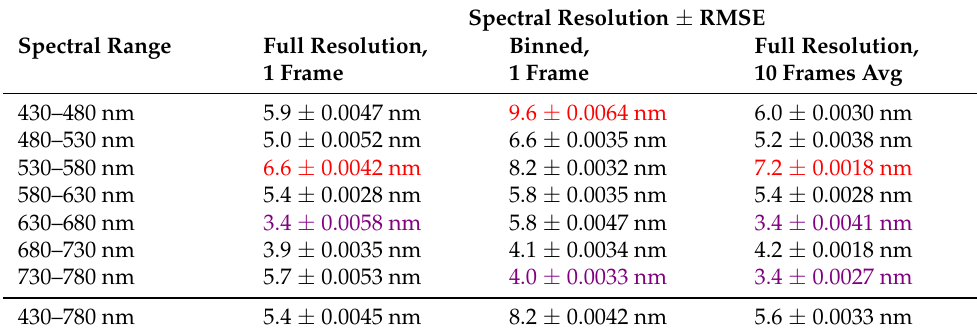
Table 5. Best estimated spectral resolution in 50 nm bands, and corresponding RMSE values for full resolution, binned, and frame-averaged data. Red and violet text identify the lowest and highest estimated resolutions,